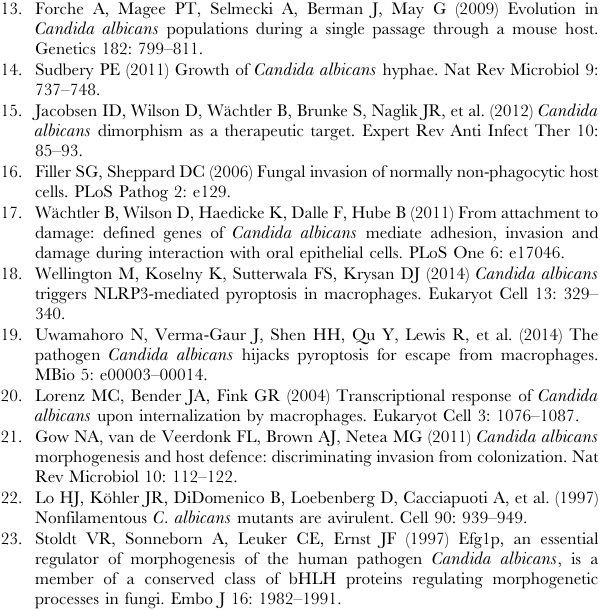
generation of the supplementary